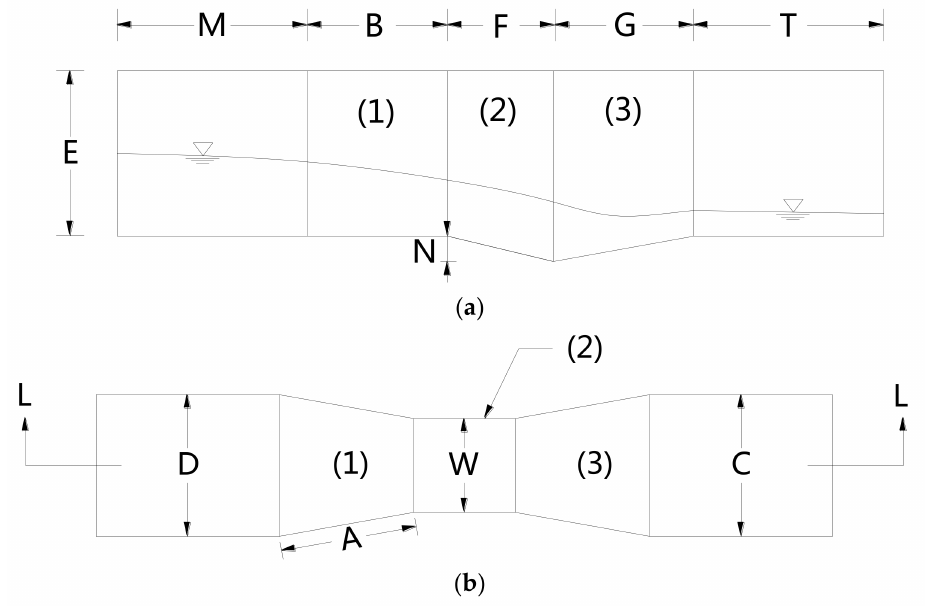
Figure 20. Sketch of the Parshall flume: ( a ) section view of L-L; ( b ) plan